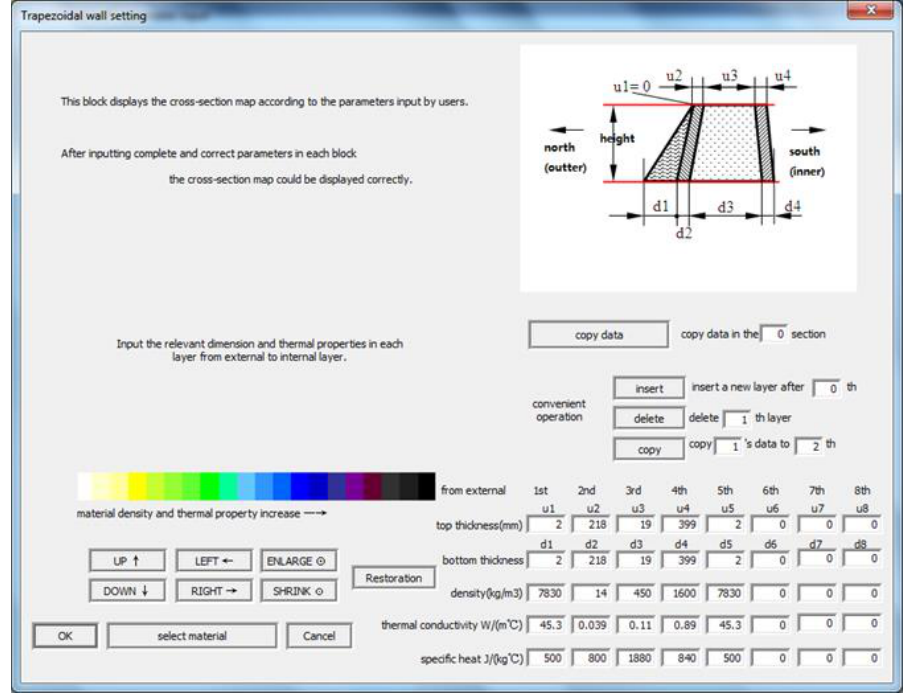
Figure 4. The interface for defining the thermal properties of the building materials.